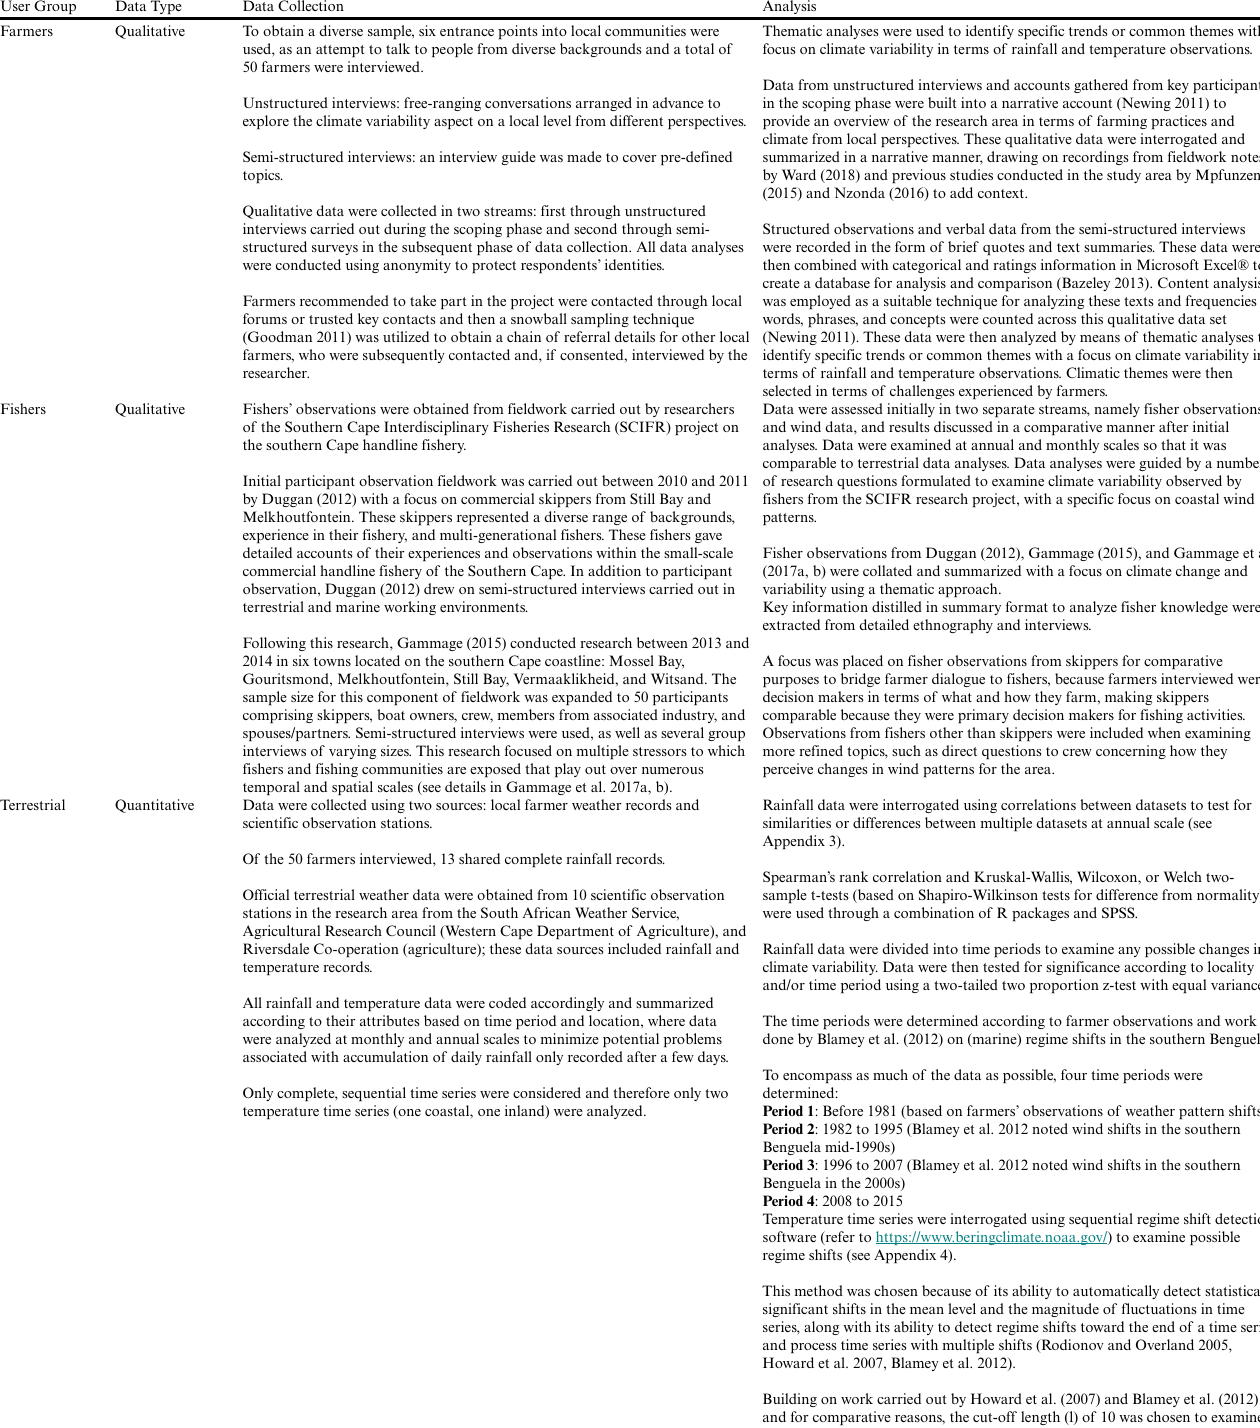
Table 1 . Local climate knowledge from multiple sources brought into dialogue for this research (detailed methods are provided in Ward